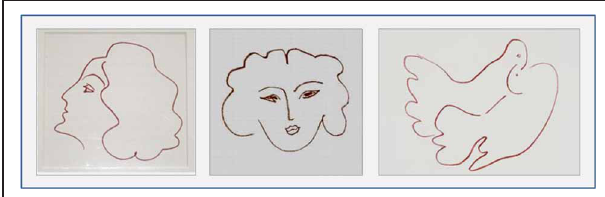
FIGURE 1 | Matisse: Lithographs No. 54: “ Marie ” (left) , No. 35: “ Ma Maîtresse ” (center) , No. 45: “ Les Colombes Amoureuses ” (right) , from the illustrations for Ronsard’s “ Florilège des Amours ”